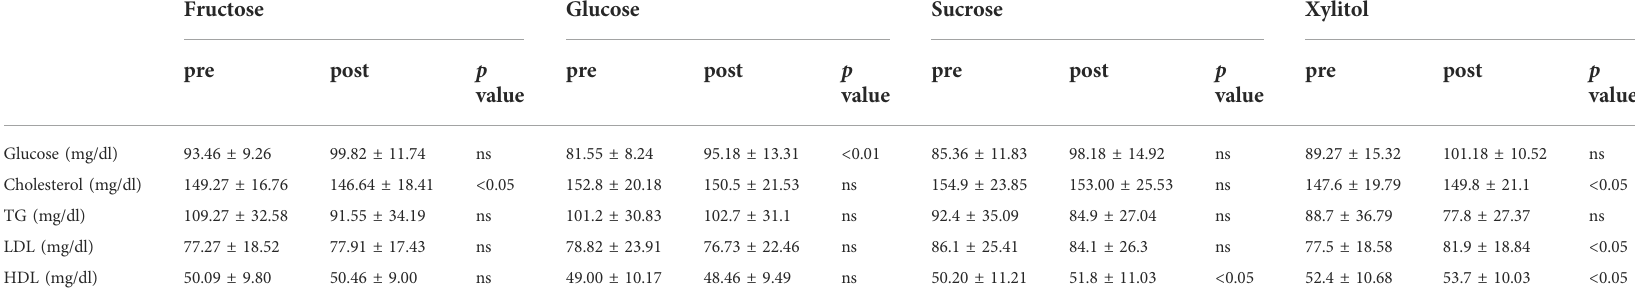
TABLE 10 Changes in glucose and lipids.